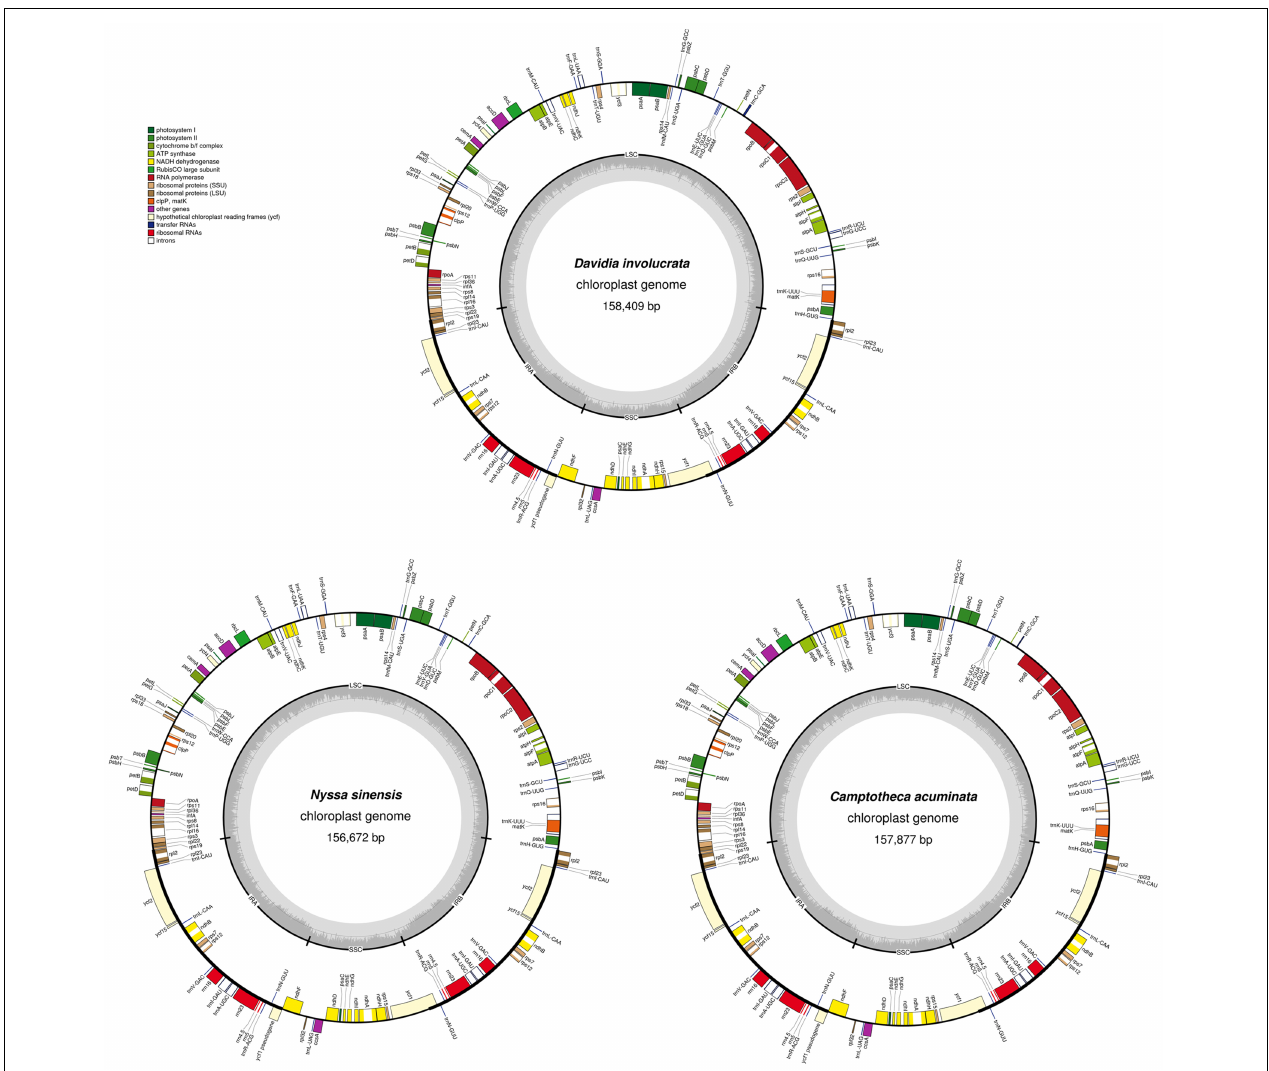
FIGURE 1 | Gene map of the Camptotheca acuminata , Davidia involucrata , and Nyssa sinensis chloroplast genomes. Genes shown outside of the outer layer circle are transcribed counterclockwise, whereas genes inside of this circle are transcribed clockwise The colored bars indicate the known protein-coding genes, t RNA, and r RNA. The dashed darker gray area of the inner circle denotes the GC content, while the lighter gray area indicates the AT content of the genome. LSC, large single-copy; SSC, small single-copy; IR, inverted repeat.